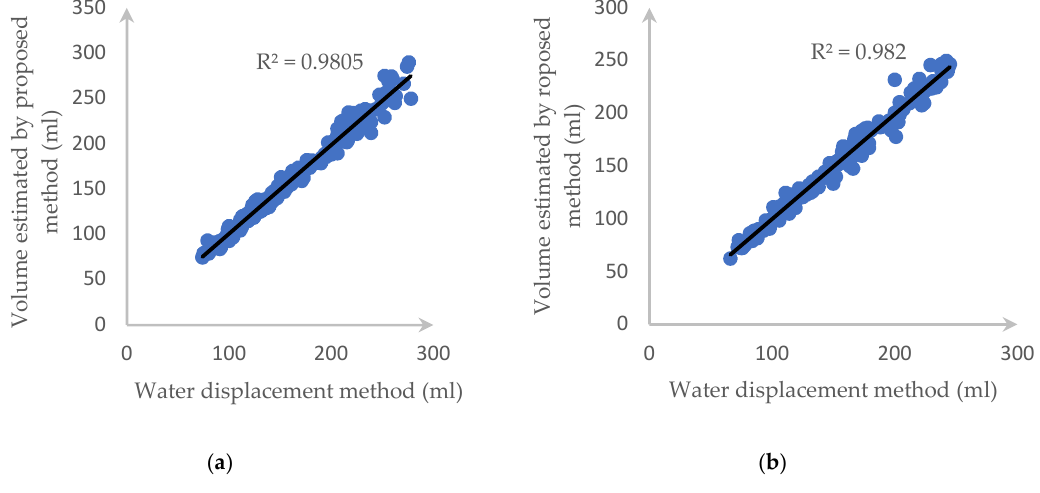
Figure 18. R 2 and the correlation between the proposed method and the water displacement method for ( a ) a carrot and ( b ) a cucumber.